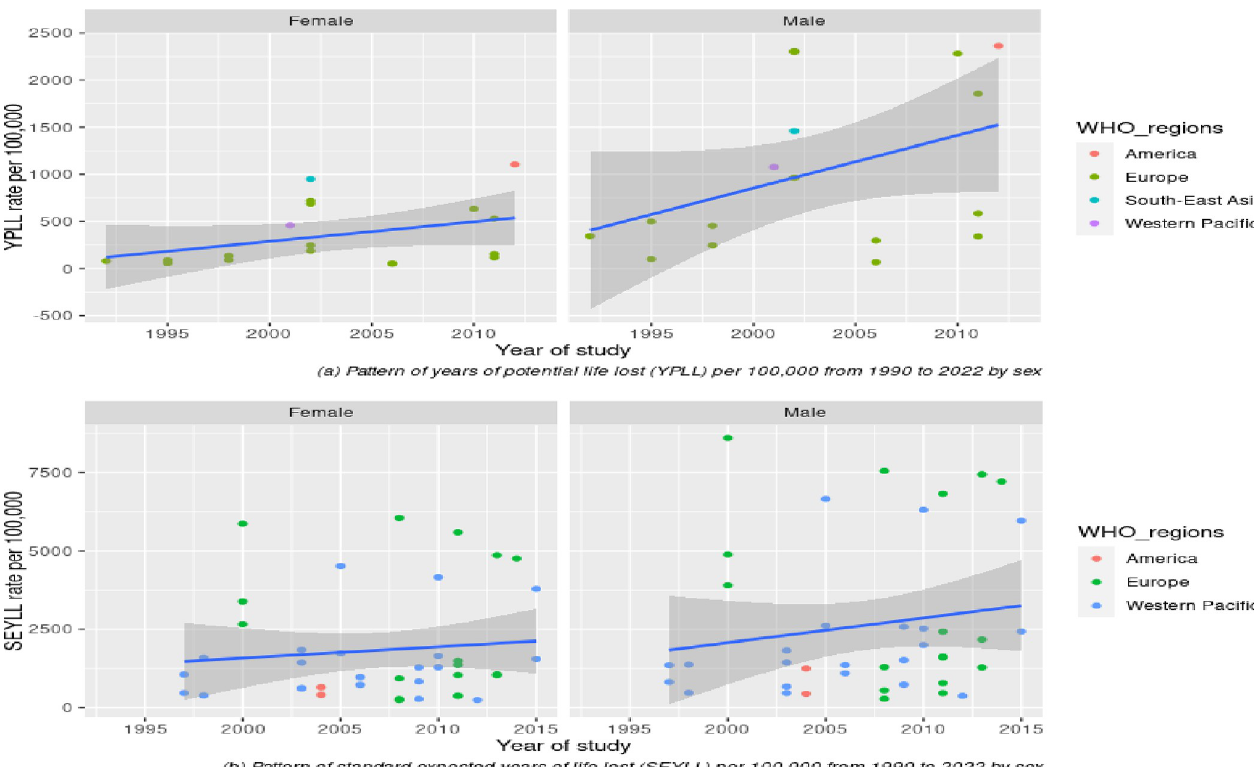
Fig 6. (a): Patterns of YPLL rate (a) and SEYLL rate (b) according to sex and WHO regions.